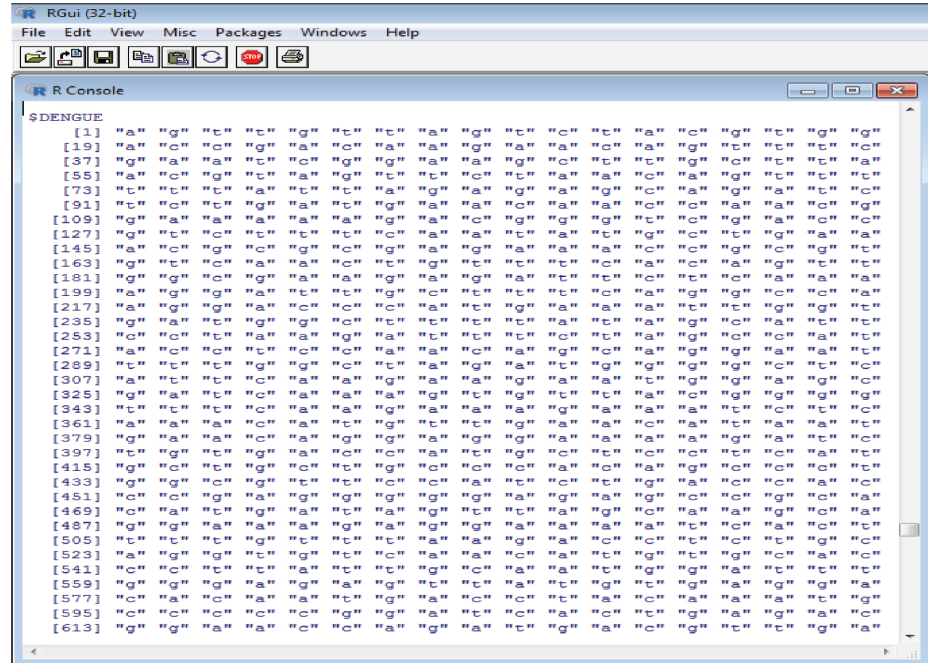
Figure 6: Top 630 bases of DENGUE DNA sequence using